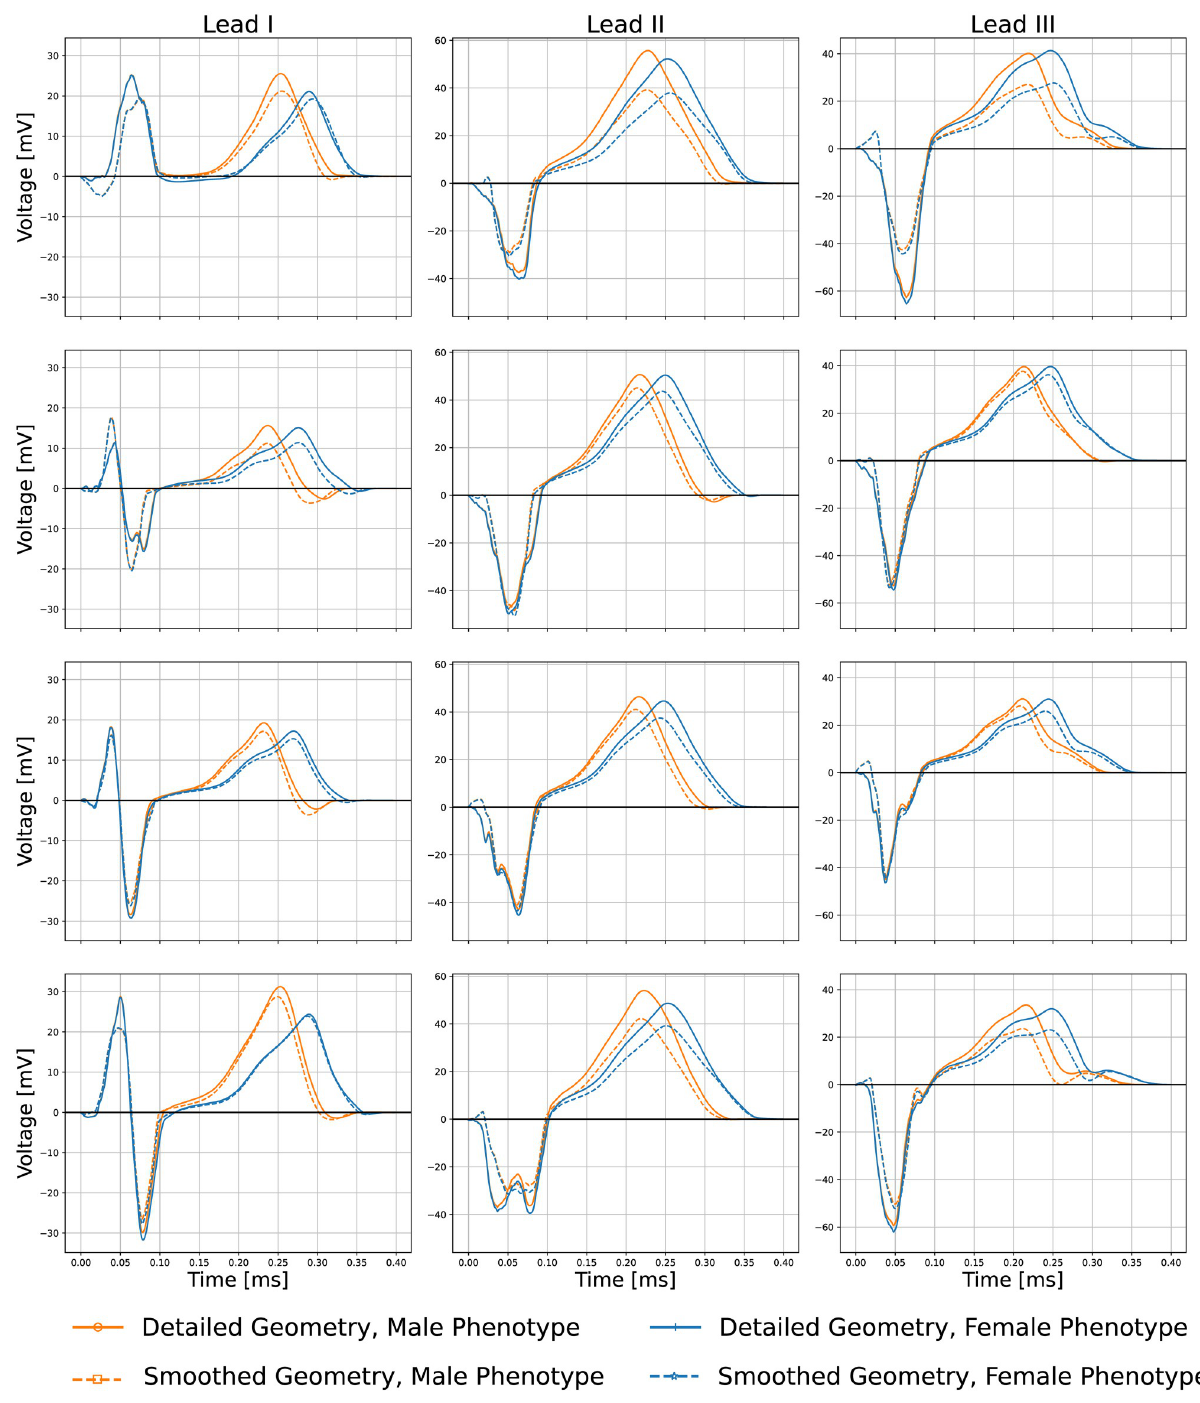
Fig 8. Lead I, II and III pseudo-ECG results for smoothed/detailed male ( A-B ) and female ( C-D ) geometries with both male/female phenotypes.